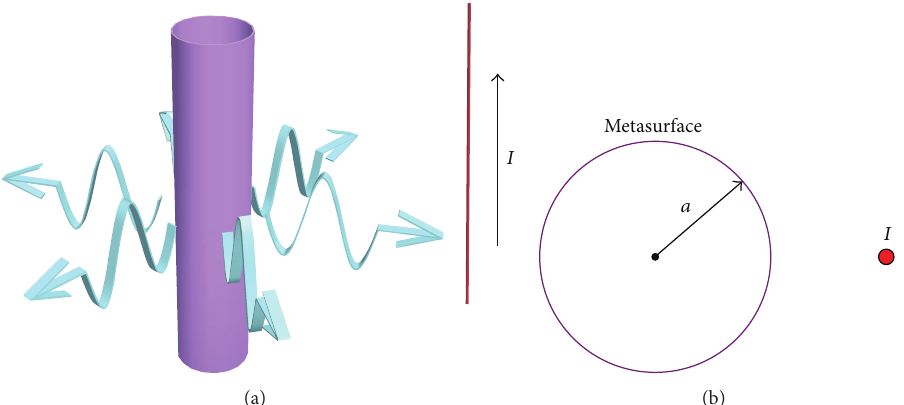
Figure1:Principleoftheproposedmodelwithacylindricalmetasurfaceandalinesource(coloronline).(a)Thethree-dimensionaldepiction. (b) The two-dimensional geometry of the cross section.